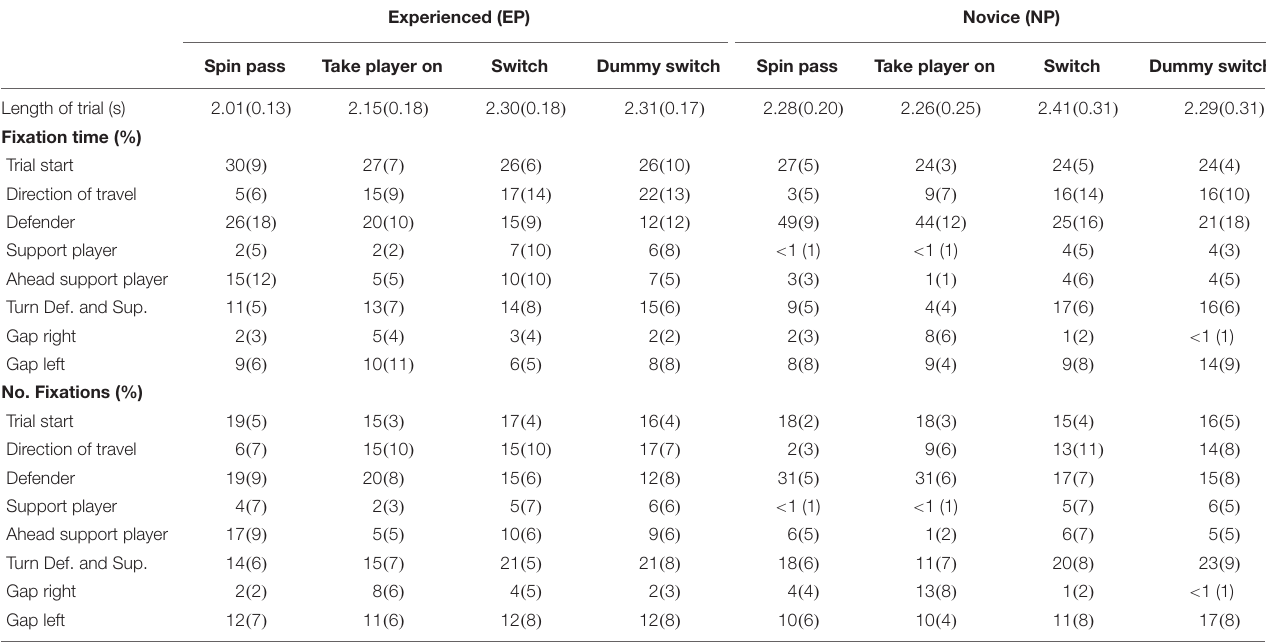
TABLE 1 | Visual search as a function of group (Experienced-EP, Novice-NP) and scenario (Spin Pass, Take-Player-On, Switch, and Dummy